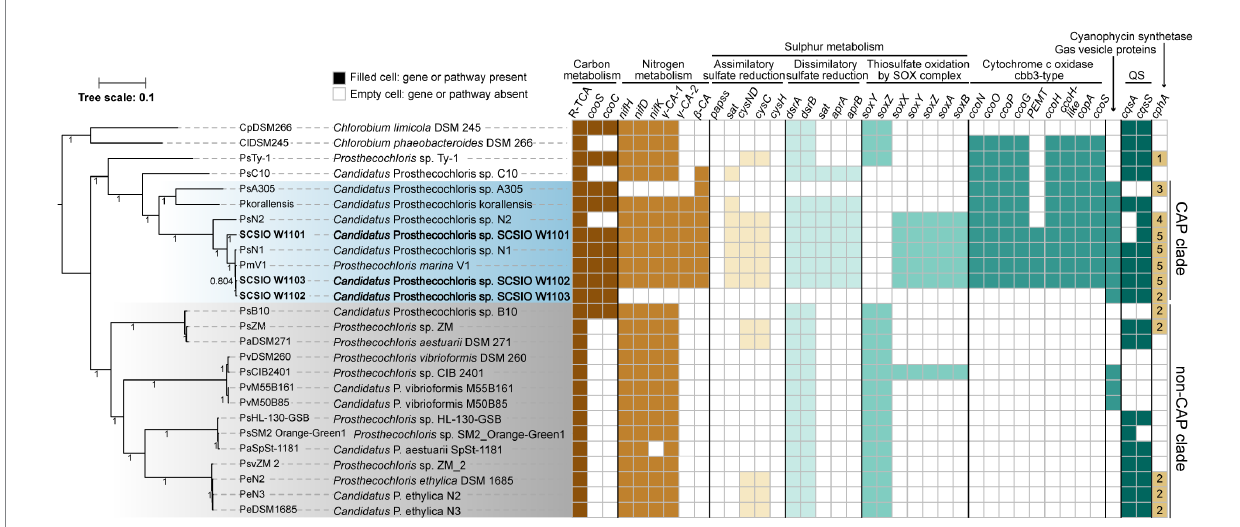
FIGURE 3 Coral-associated Prosthecochloris (CAP) genomes show specialized metabolic capacities. Phylogenetic relationship of Prosthecochloris genomes and differences in metabolic capacities. CAP genomes are in blue shading, non-CAP genomes are in gray shading, and the names of new identified Prosthecochloris genomes in this study are in bold format. The phylogenetic trees of concatenated genes were constructed by FastTree. Different colors of filled cells indicate different classifications of genes, but not the copy numbers of the genes, except that the numbers in the cells of gene cphA indicate the copy numbers. R-TCA, reductive citrate